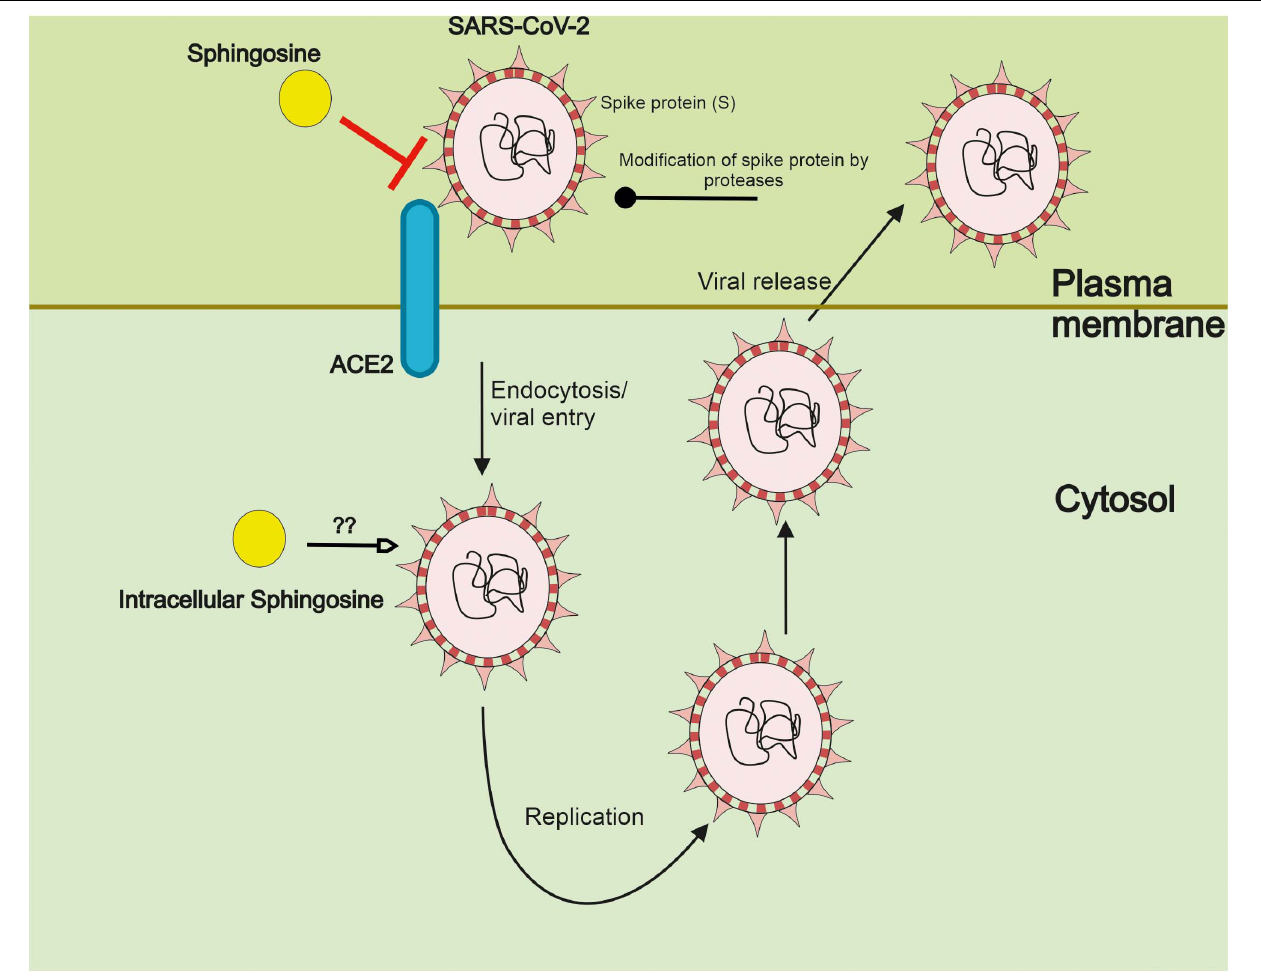
FIGURE 2 | Sphingosine inhibits the interaction of SARS-CoV-2 with its ACE2 receptor. SARS-CoV-2 interacts with its ACE2 receptor on the cell surface via the spike protein (S). Following activity of cell surface protease, the virus is taken up into the cells by membrane fusion events and endocytosis. Subsequent steps in the life cycle of SARS-CoV-2 include viral replication and packaging with the release of new particles to infect further cells. Recent studies employing pseudoviral particles of SARS-CoV-2 indicate that sphingosine can bind ACE2 hindering the interaction of the S protein with the receptor in human epithelial cells. This results in a reduced cell entry and probably infectivity of SARS-CoV-2. Sphingosine and sphingolipids are abundantly present in cell membranes. Sphingosine is here depicted in a schematic way but with the caution that it is not a compound in the classical sense of soluble drug interactions. It remains to be shown whether intracellular sphingosine may influence SARS-CoV-2 at other steps also following viral